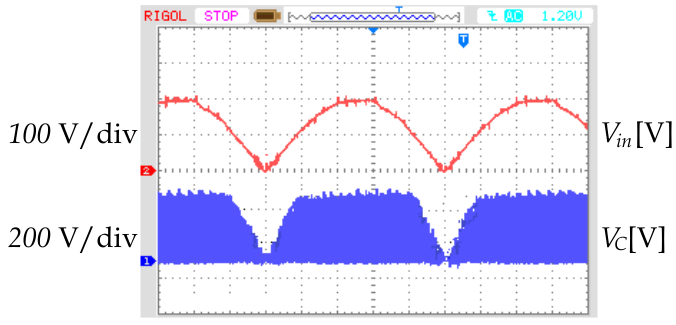
Figure 11. Voltage waveform of the resonant capacitor during a half line